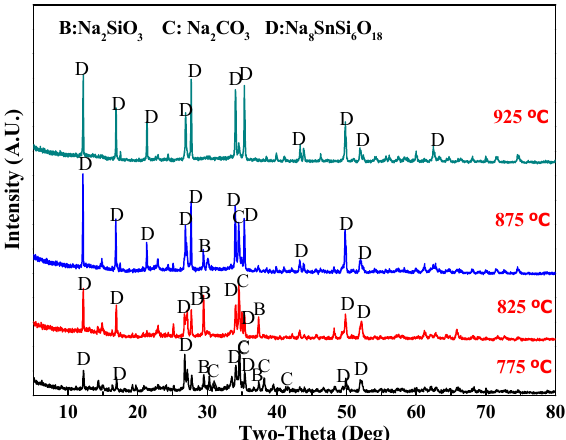
Figure 9. XRD patterns of the samples roasted at different temperatures (Time: 60 min; SiO 2 /SnO 2 molar ratio: 7:1).